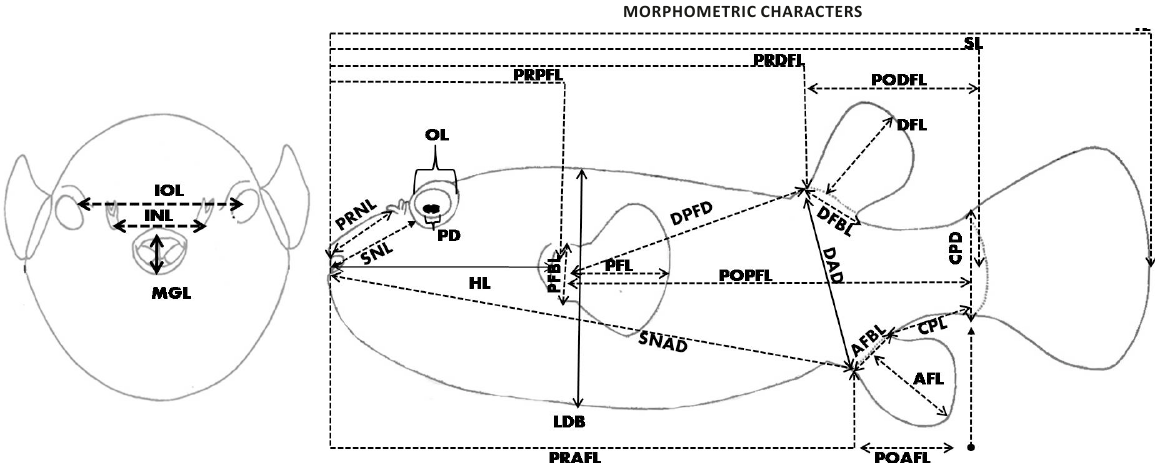
Figure 2. Typical Truss Morphometric Network (TMN) of marine Pufferfish & Porcupinefish.